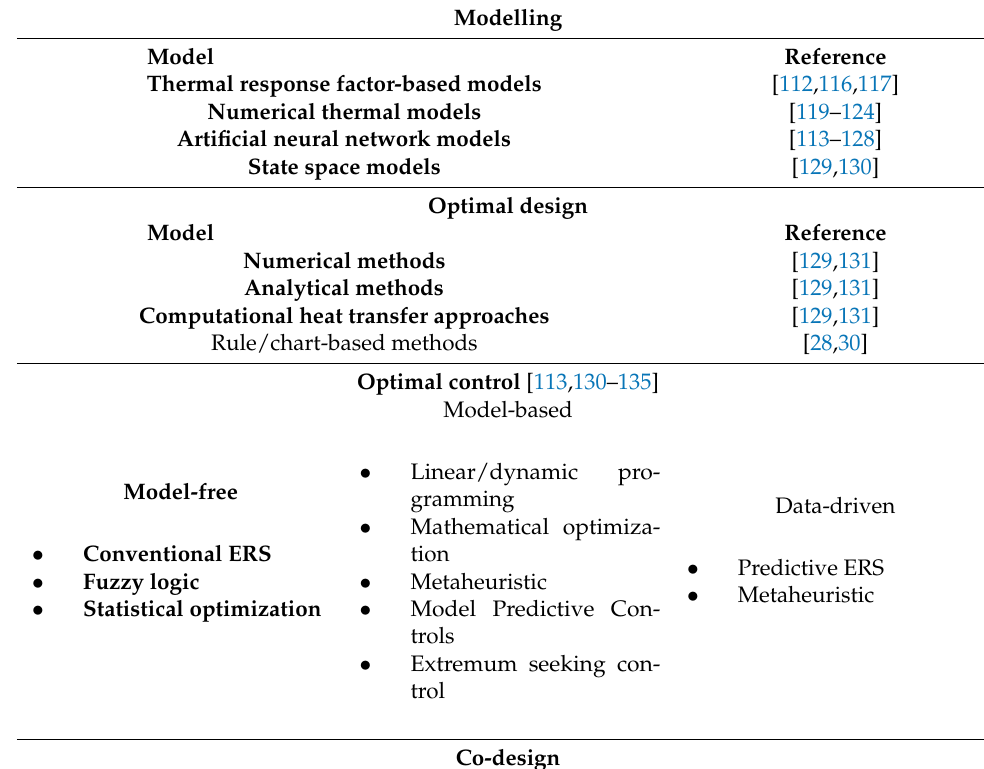
Table 4. Classification of GSHP design and control